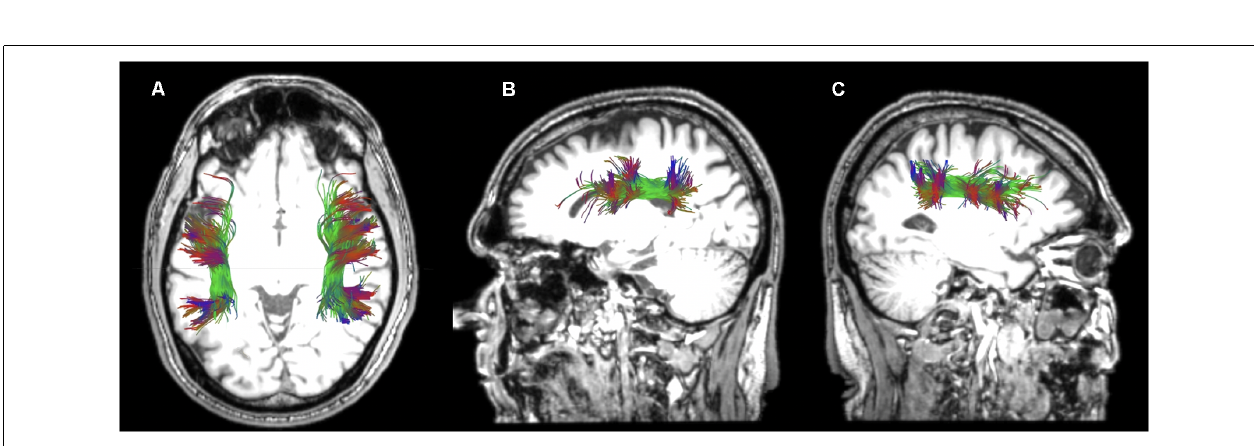
FIGURE 6 | Horizontal (A) and sagittal views of the reconstructed left (B) and right (C) superior longitudinal fasciculus III of a healthy participant in native